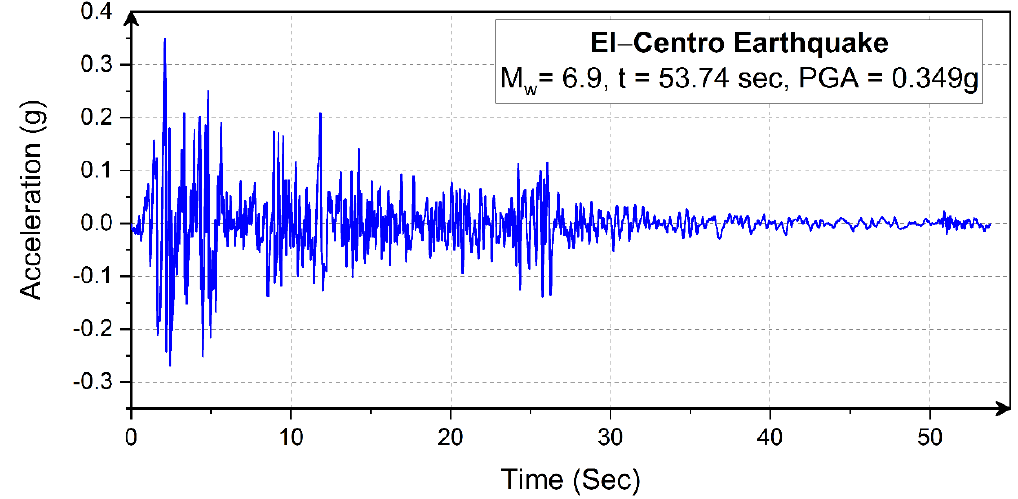
Figure 2. El-Centro earthquake data used for time – history analysis (Source: [26]).